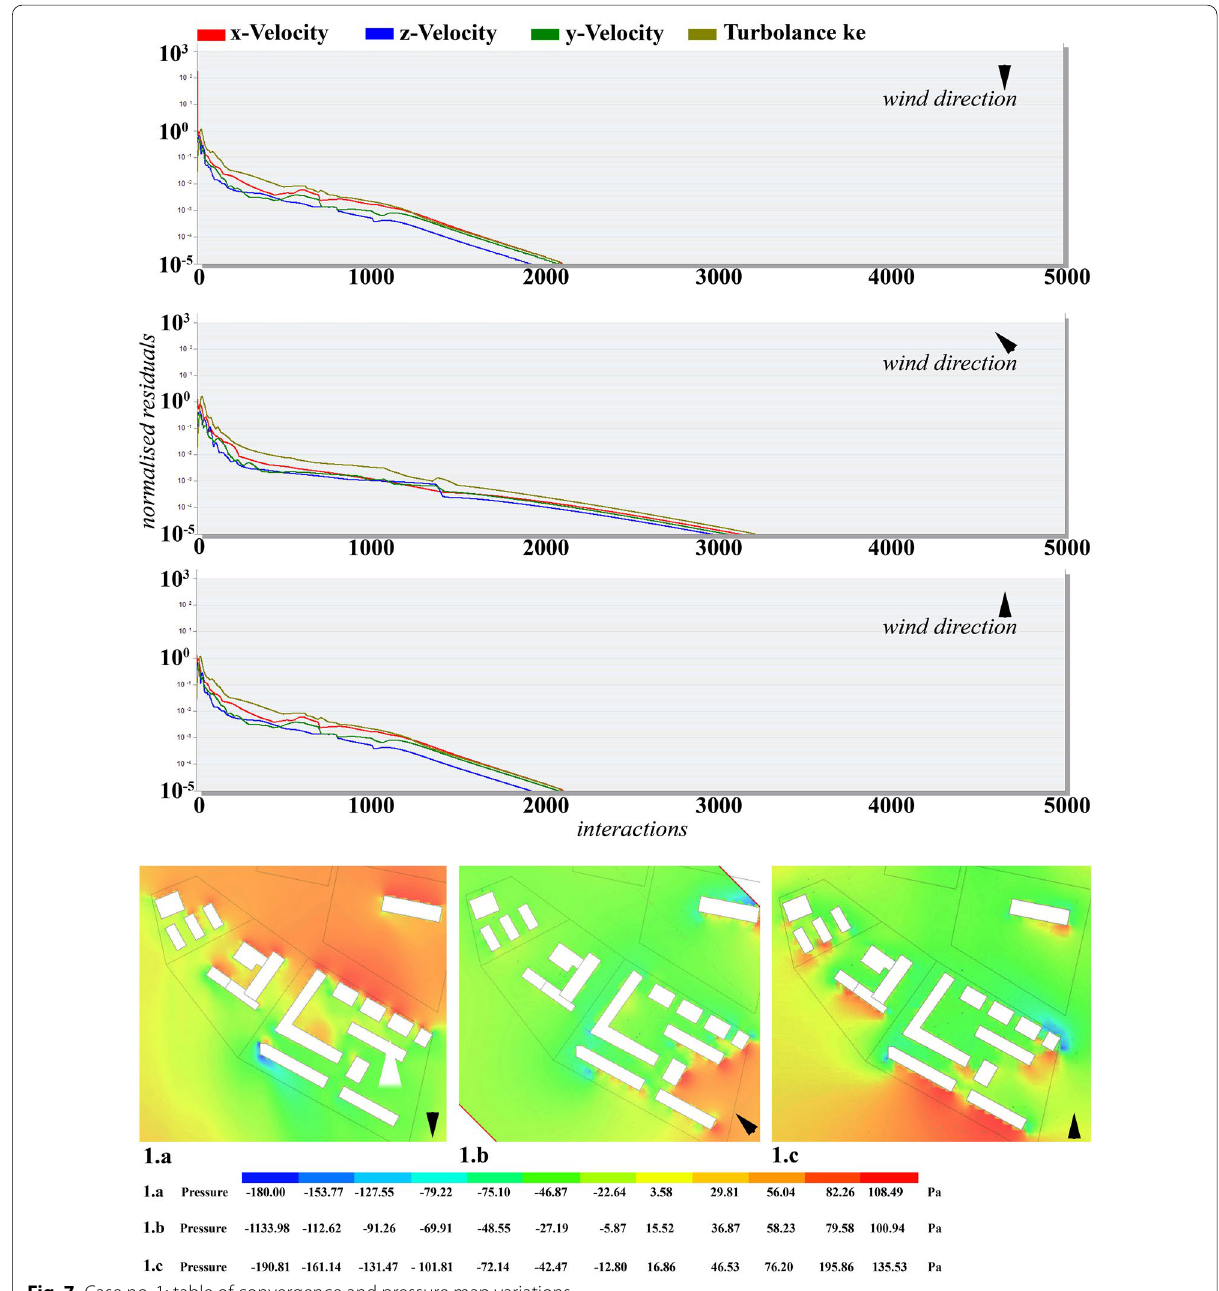
Fig. 7 Case no. 1: table of convergence and pressure map